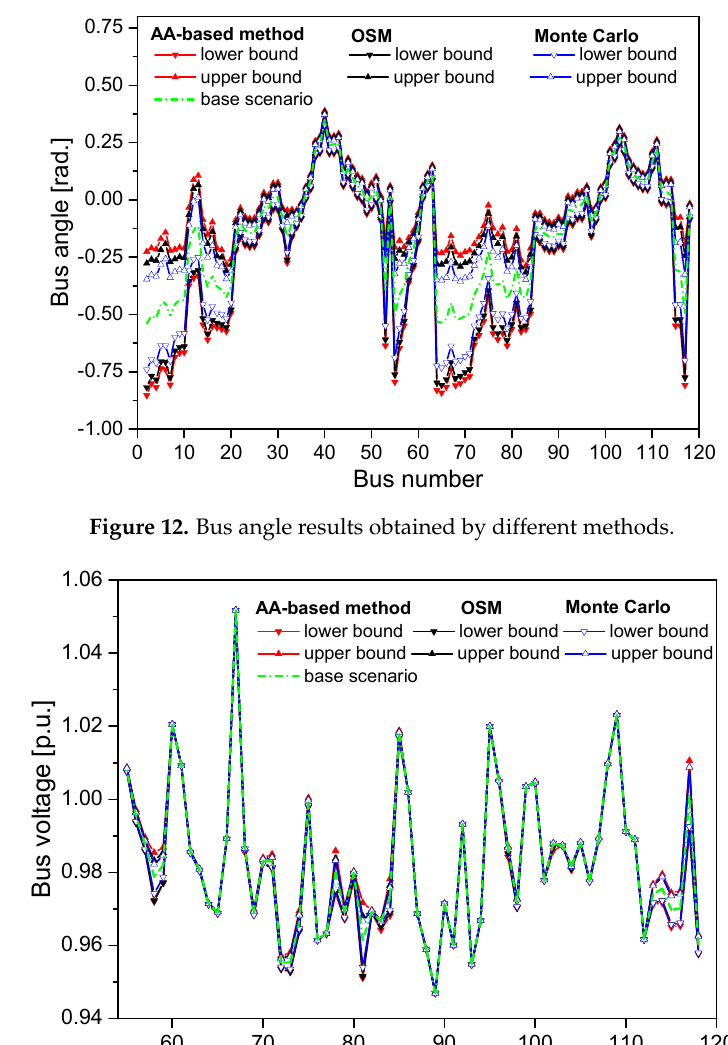
Figure 11. Layout of the IEEE 118 bus system with different wind power farms.